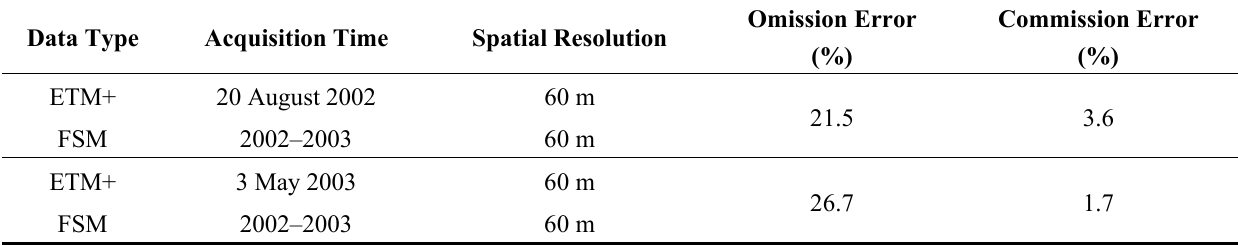
Figure 9. Validation of the coal fire information that was extracted from 2002 and 2003 Landsat data using the coal fire map by the field survey from 2002 to 2003, with the three-year results of coal fires stacked for the overlay analysis. Table 3. Validating the results of the coal fires based on 2002 and 2003 Landsat data using the coal fire map from the field survey. FSM: Field Survey